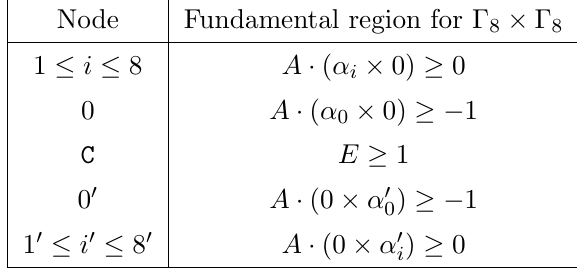
Table 6. Fundamental region for HE in d =